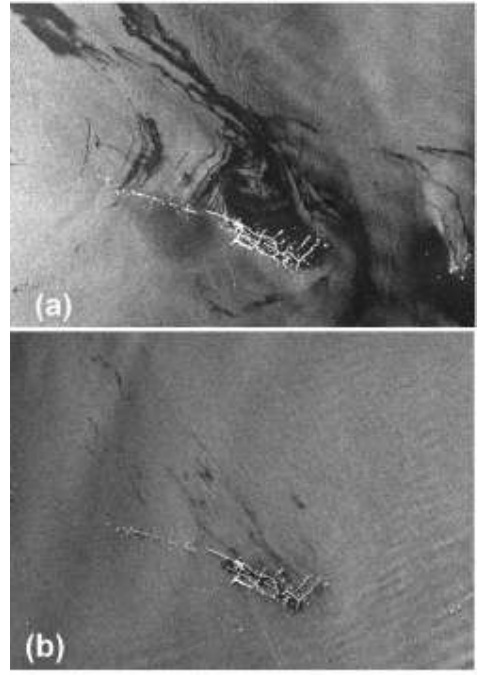
Figure 3. Identified (a) & Non-identified (b) Oil Patterns on